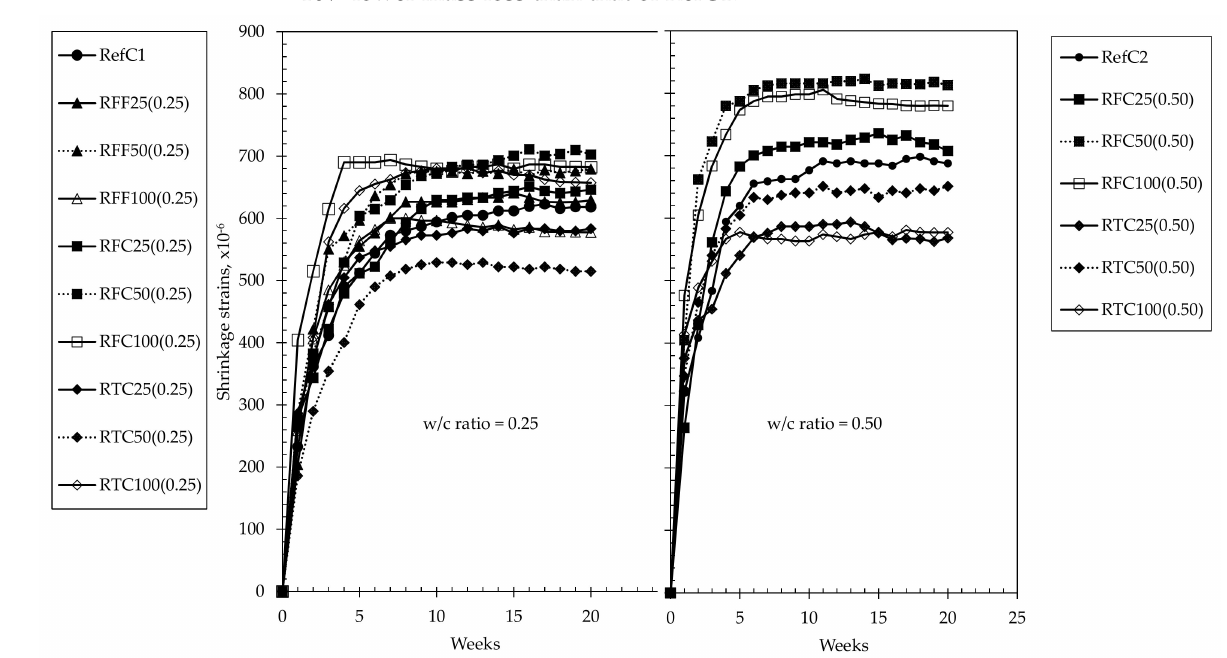
Figure 4. Drying shrinkage of concrete mixtures investigated up to 20 weeks.